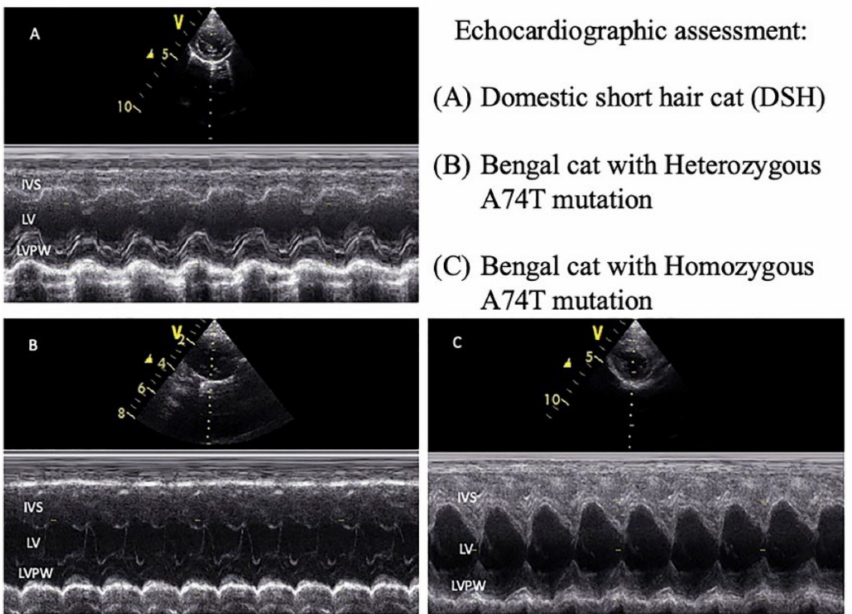
Figure 1. Echocardiographic assessment of left ventricular wall in the normal cat. The representative figures were visualized by the motion mode (M mode) at the papillary muscle view in the short-axis view. ( A ) DSH cats, ( B ) heterozygous A74T mutation in Bengal cats, and ( C ) homozygous A74T mutation in Bengal cats. IVS = interventricular septum; LV = left ventricle; LVPW = left ventricular proximal wall. Schemes follow the same formatting, V represents the marker